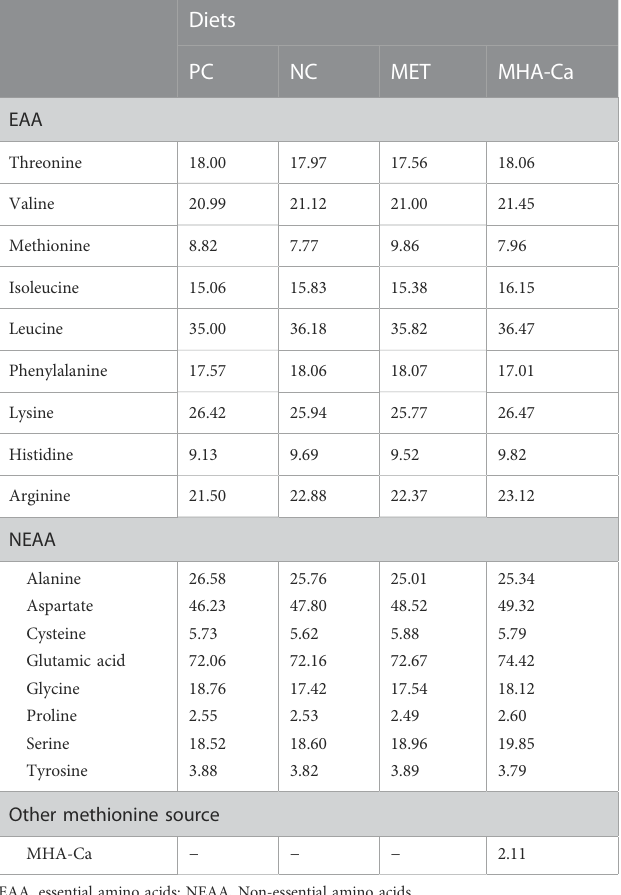
TABLE 2 The amino acid composition and MHA-Ca content of experimental diets (g/kg dry